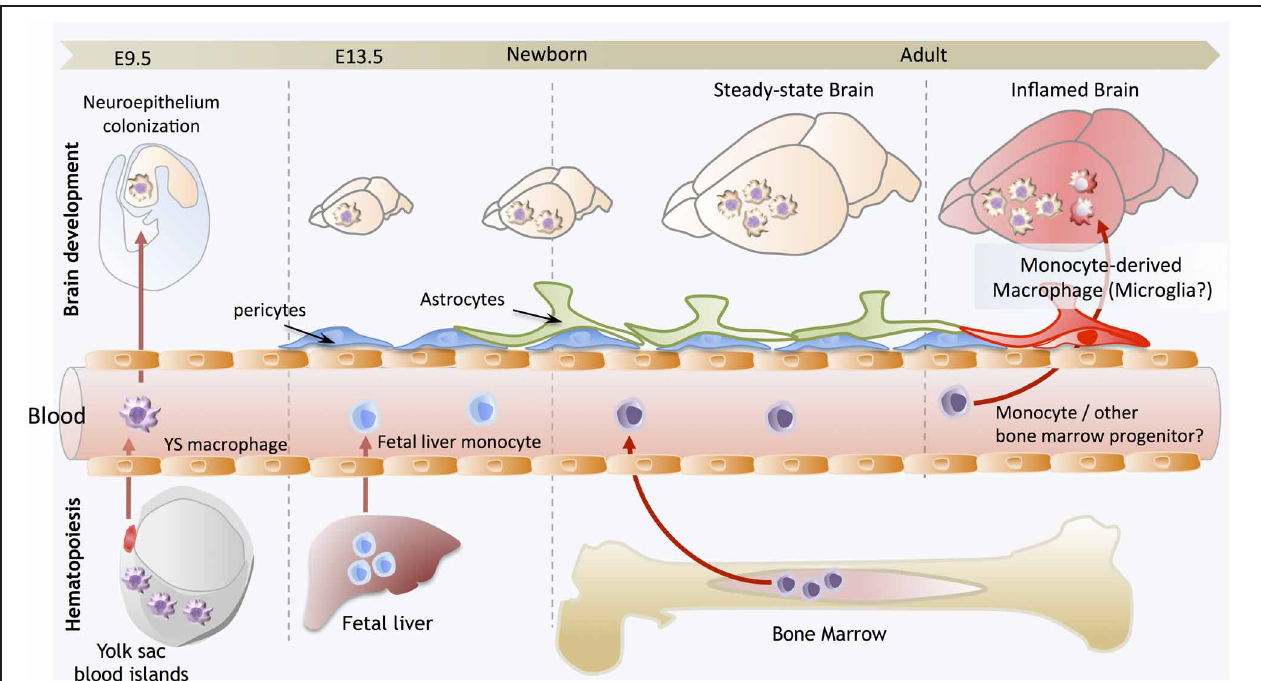
gestation and post-natal development as well as in the injured adult brain in reaction to inflammation. Nevertheless, during certain inflammatory conditions found for example after bone marrow transplantation, the recruitment of monocytes or other bone marrow-derived progenitors can supplement the microglial population to some extent. However, we do not understand yet whether these cells persist and become integrated in the microglial network, or are a temporary addition to the endogenous